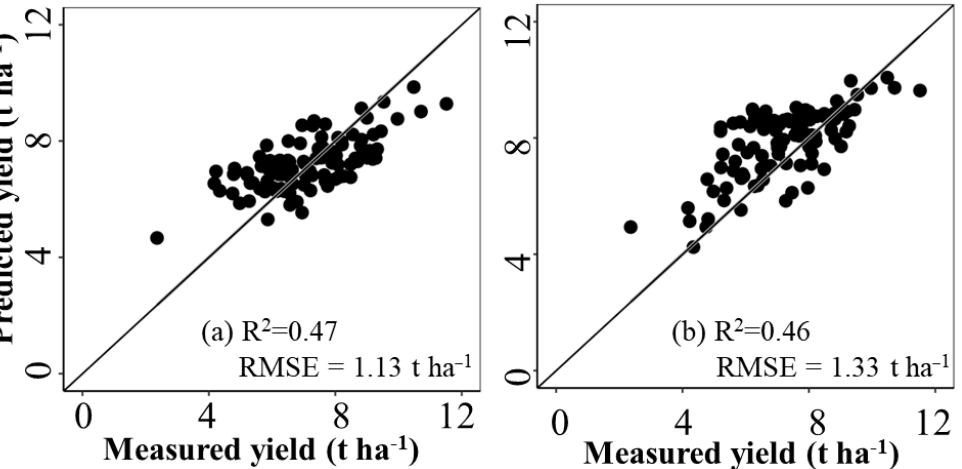
Figure 9. Predicted yield (tons per hectare) derived from transfer learning models ( a ) and data assimilation ( b ).